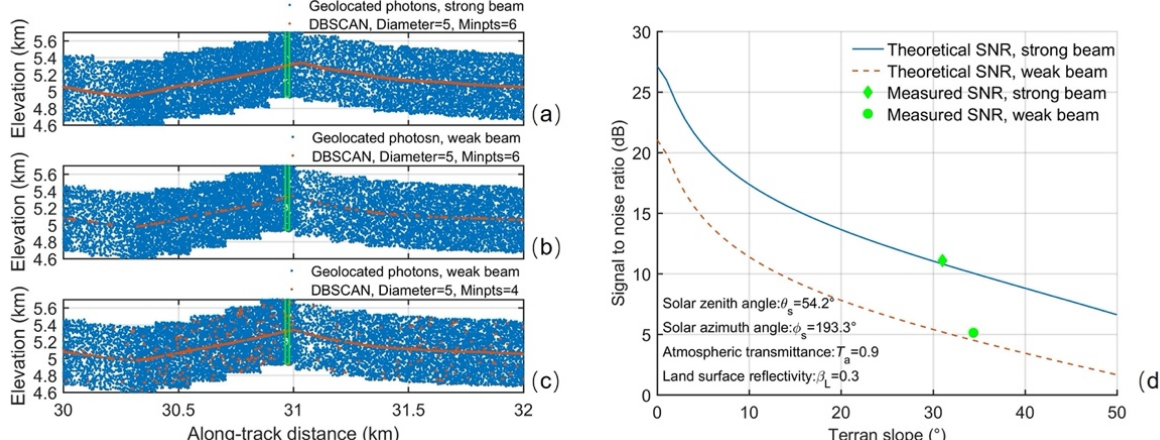
Figure 5. Measured geolocated photons in an ICESat-2 ′ s along-track segment in the first study area (i.e., ATL03_20181207065658_ 10640102_002_01, GT1R) and the SNR curves for the strong and weak beams. ( a ) Measured noisy geolocated photons (blue points) and the detected signal photons (red points) for the strong beam with the Minpts of 6. The x -axis represents relative ICESat-2 along-track distance and the y -axis represents the ellipsoid height in kilometers. ( b ) Measured noisy geolocated photons and the detected signal photons for the weak beam with the Minpts of 6. ( c ) Measured noisy geolocated photons and the detected signal photons for the weak beam with the Minpts of 4. ( d ) Theoretical SNRs of the strong beam (using blue solid curve) and the weak beam (using red dashed curve). In ( d ), two typical SNR values are marked by green points and were calculated by the measured signal and noise photons in the green boxes in ( a , b ) for the strong and weak beams,